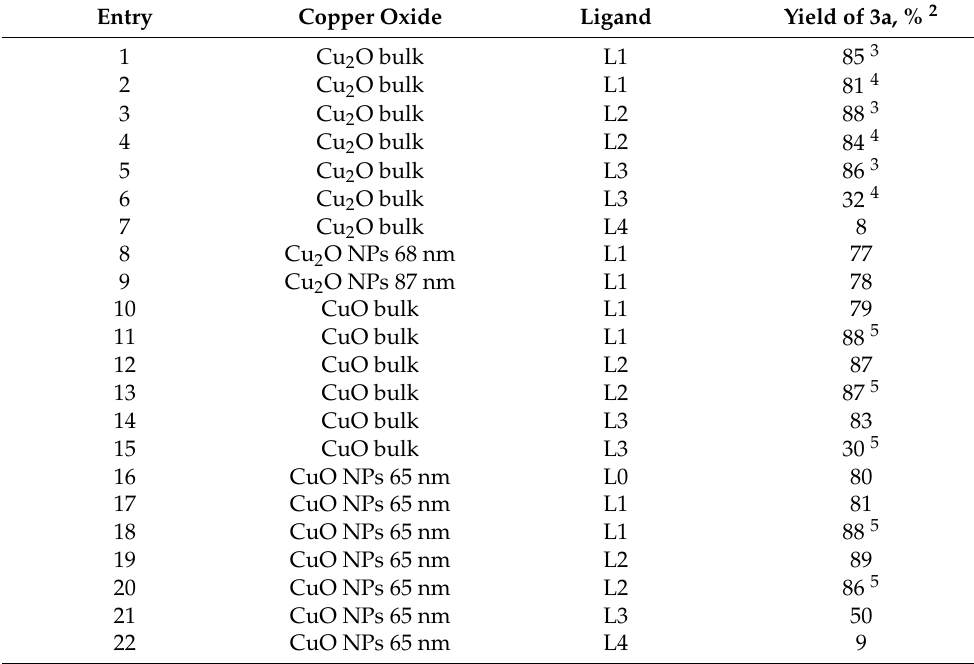
Table 2. Arylation of n -octylamine ( 1 ) with iodobenzene ( 2a ) in the presence of Cu 2 O and CuO 1